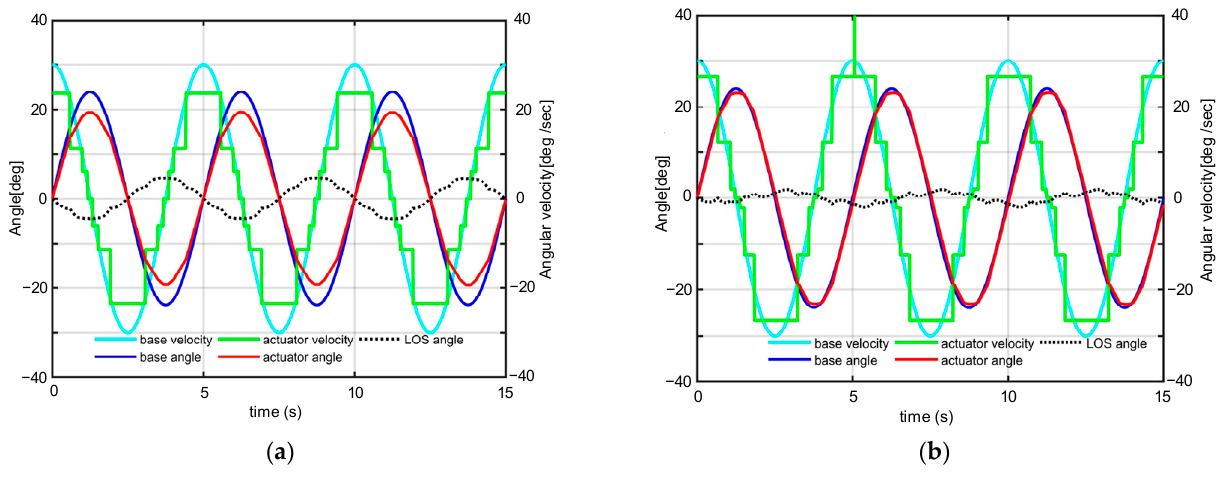
Figure 9. The performance of the stabilized control in simulation: ( a ) the typical controller; ( b ) the proposed scheme.